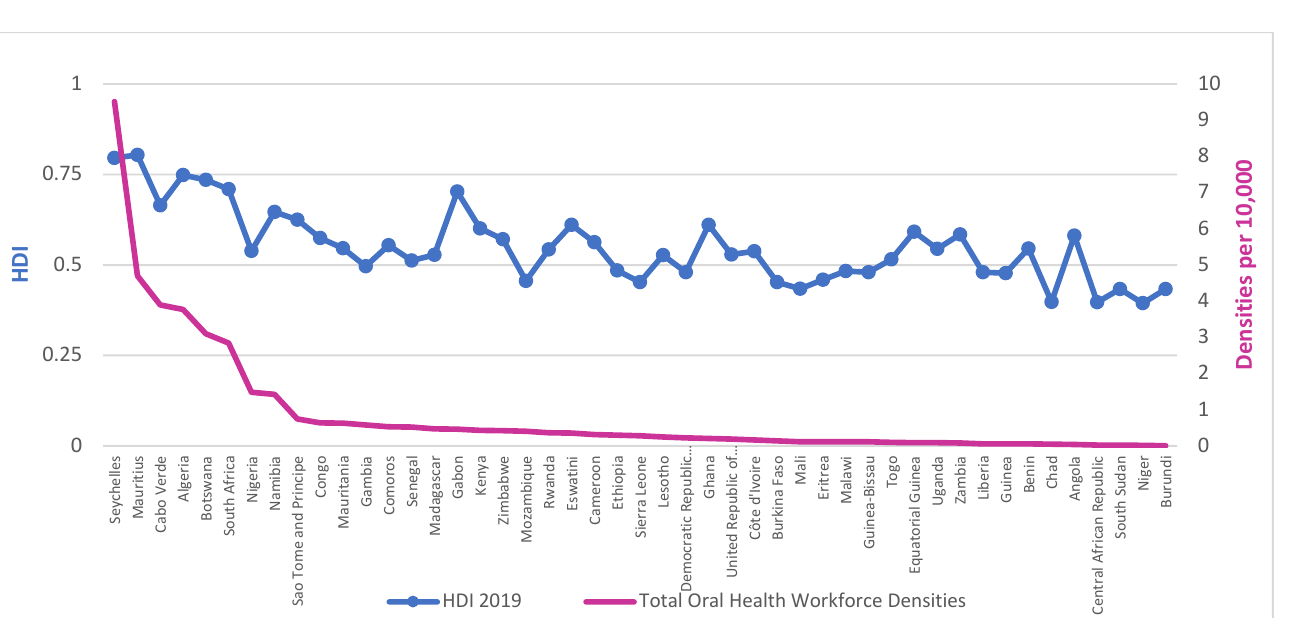
Figure 2. Densities of dentists per 10,000 population and Human Development Index (HDI) for the AFR, 2019. Source: The workforce data are based on a combination of the latest available data from the NHWA data platform and King’s College London survey. HDI was collected from the latest Human Development Report from the United Nations Development Programme (UNDP).